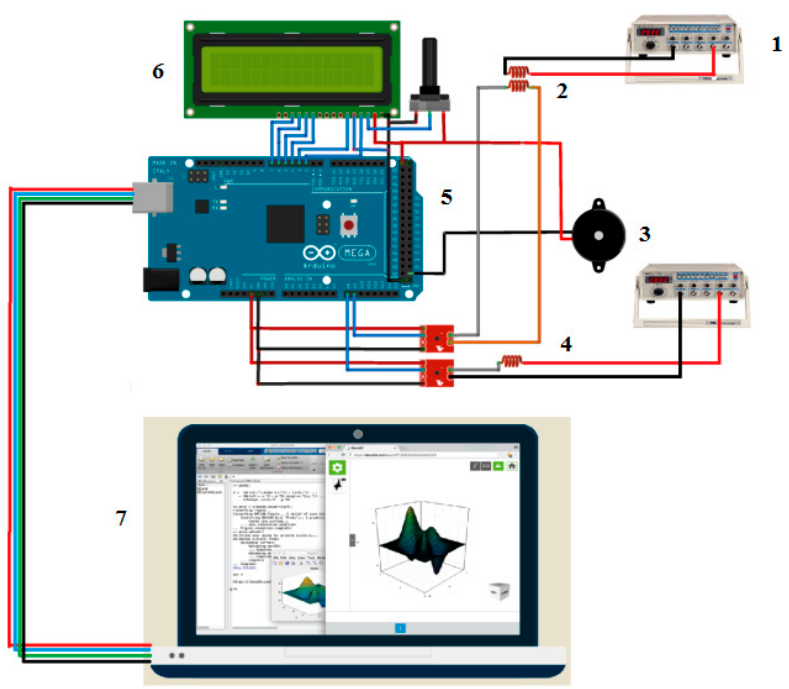
Figure 7. Designing of ECECT Drive Circuit.1: AC signal; 2: Absolute Probe; 3: Buzzer; 4: Differential Probe; 5: ATMEGA 2560 microcontroller; 6: LCD Display; 7: Computer.